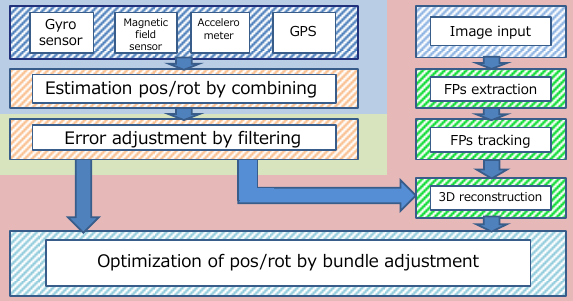
Figure 2. Flow of the POS and camera integration